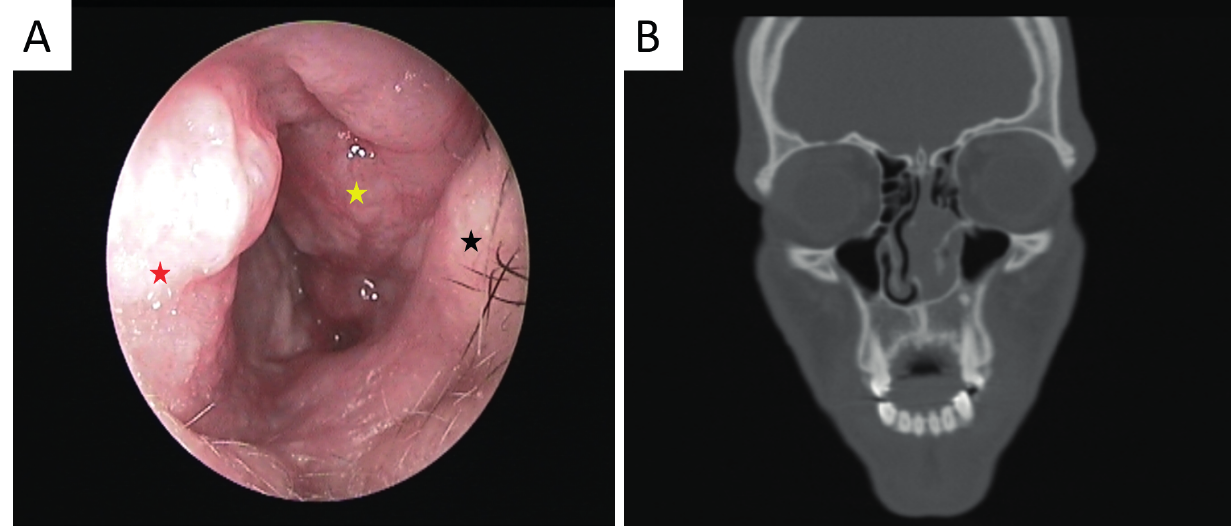
Figure 2. Intranasal image and CT-scan at first consultation. A. Intranasal image of the left nasal cavity. The red asterisk indicates the nasal septum; the yellow asterisk indicate the mucosal tumour that was found superiorly from the inferior turbinate in the nasal cavity (black asterisk). B. CT-scan of the paranasal sinuses: coronal view. Thickening of the soft tissue in the left nasal cavity, with extension to the lateral side. There is no destruction of sur- rounding